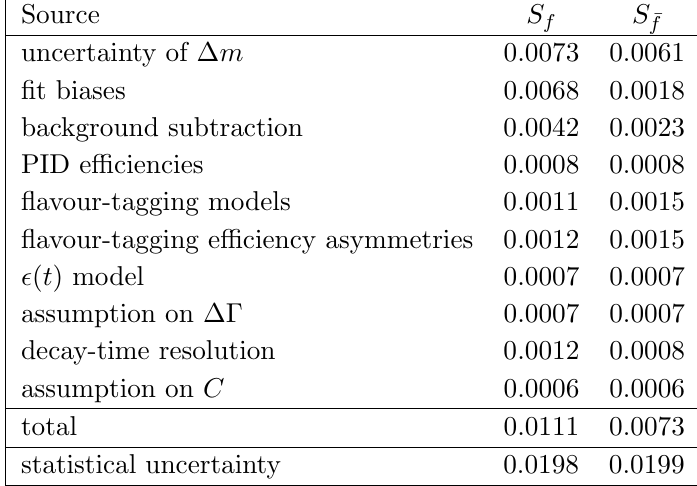
Table 1 . Systematic uncertainties on the CP asymmetries S f and S (cid:22) sum in quadrature of the individual contributions.